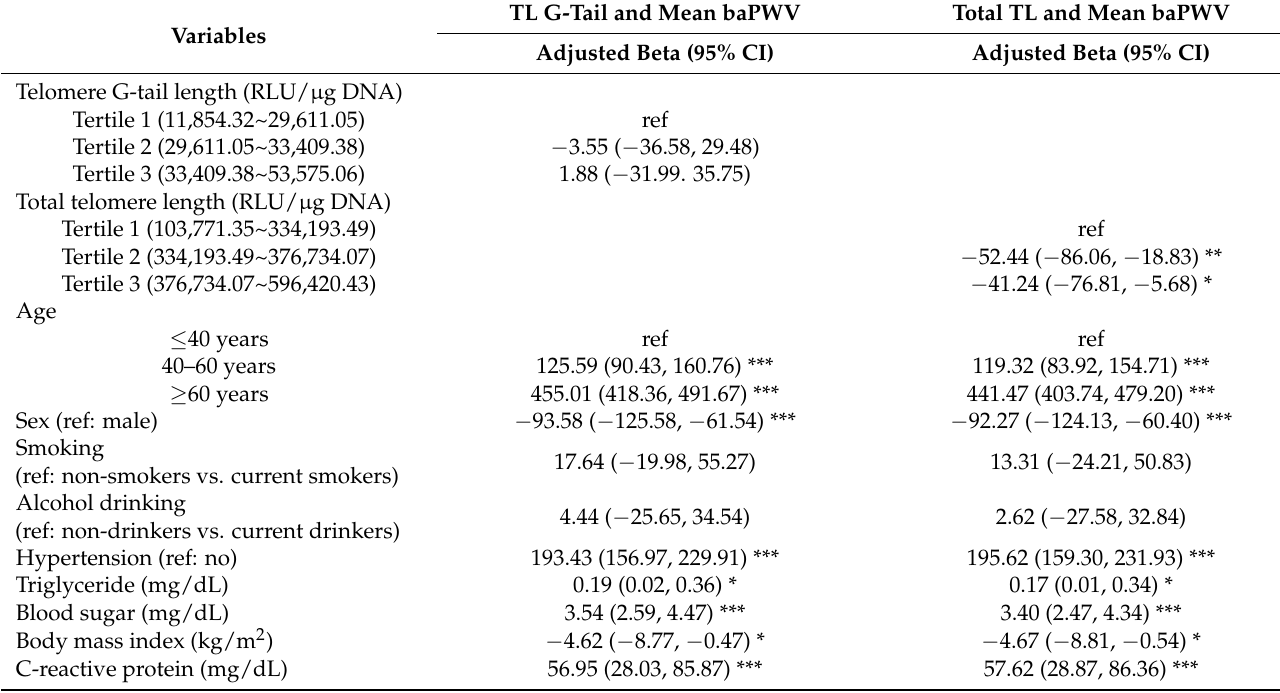
Table 4. Multivariate linear regression of telomere length and brachial–ankle pulse wave velocity ( n = 1056).